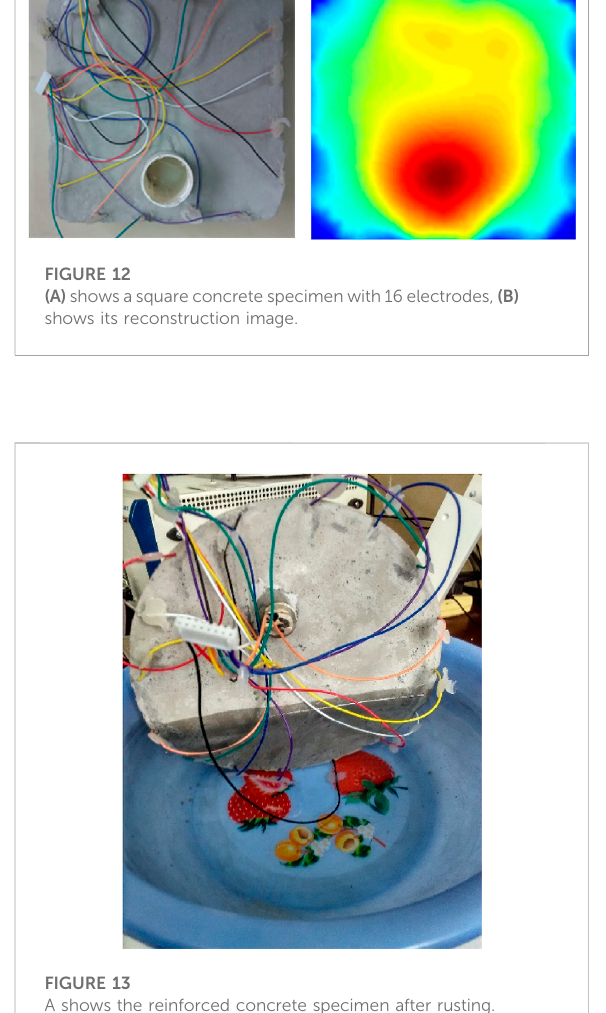
Figure 5. From the order of activity of metals table, considering the economy, the design based on the experiment of the production of electrodes material selected copper, electrode size width of about 3cm, length of about 4cm, thickness of about 3 mm.